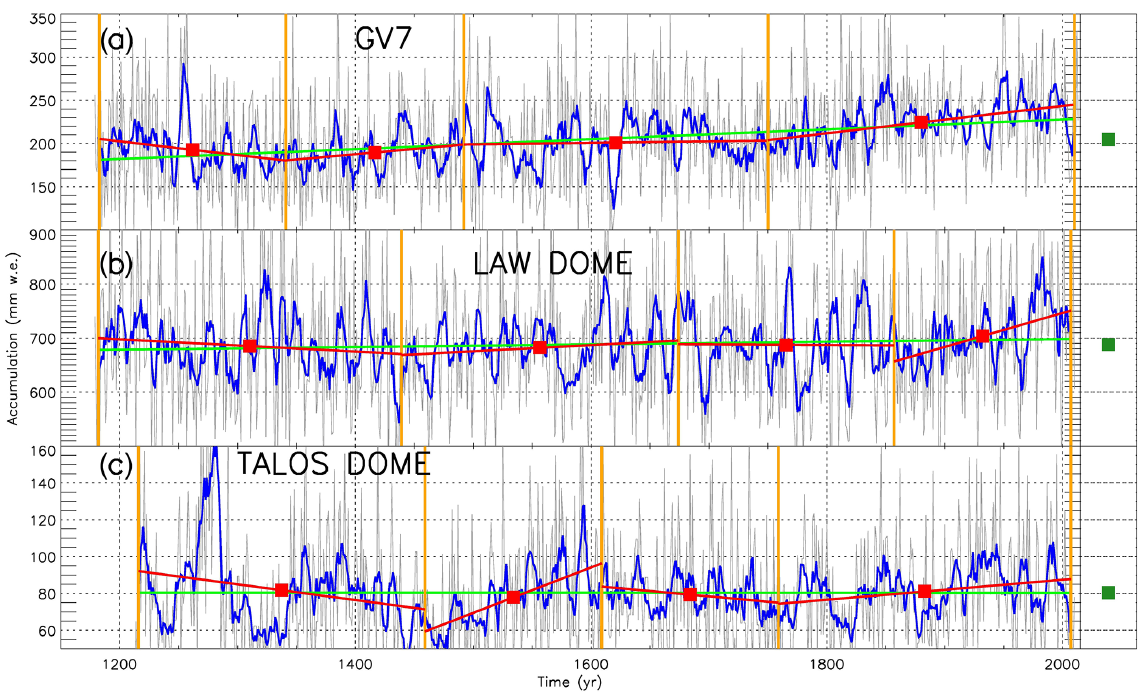
Figure 7. (a) GV7 stacked record (gray line) with its 7-year smoothing average (blue line); green line represents trend for the 1179–2013CE record. Vertical yellow bars show breaking points (1183, 1341, 1492, 1750 and 2010CE) calculated following Tomé and Miranda (2004). Red lines and filled squares show partial trends and mean accumulation (with standard deviation error bars) for each subperiod defined by breaking points. The green-filled square with the error bar highlights mean accumulation at the site and its standard deviation, respectively, for the whole period (1179–2013CE). (b) Same as panel (a) but for Law Dome ice core for the period 1179–2013CE with breaking points at 1182, 1439, 1674, 1857 and 2007CE. (c) Same as panel (a) but for Talos Dome ice core for the period 1216–2010 CE with breaking points at 1216, 1459, 1609, 1759 and 2007CE. Table 3. Values of trend (Tr, mmw.e.decade − 1 ), associated significance ( p value) and mean accumulation rate ( M , mmw.e.yr − 1 ) for GV7 stacked, Law Dome and Talos Dome records smoothed using a 7-year running average. The time intervals reported in the table correspond to the different periods defined by breaking point